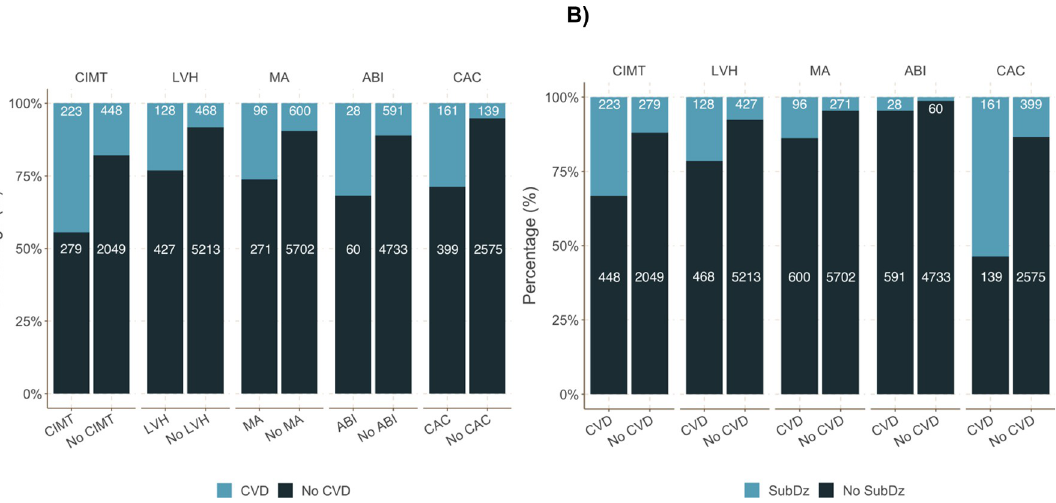
Fig 3. Pooled frequencies and percentages of: (A) Incident CVD by SubDz and (B) present SubDz by incident